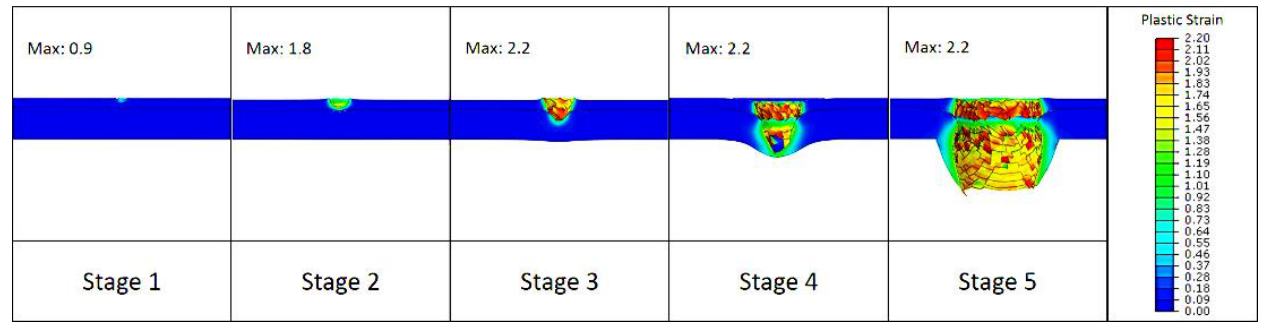
Metals 2022 , 12 , x FOR PEER REVIEW